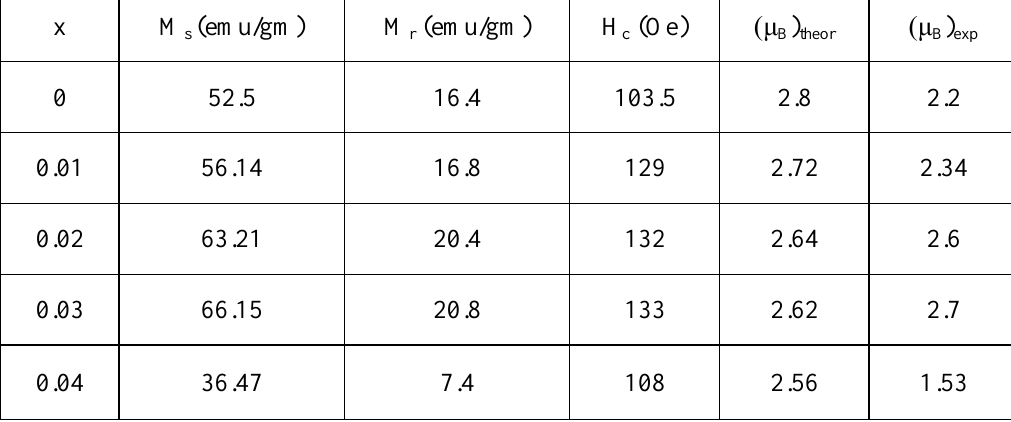
Table 3: The values of saturation magnetization, remanence, coercivity and magnetic moment of